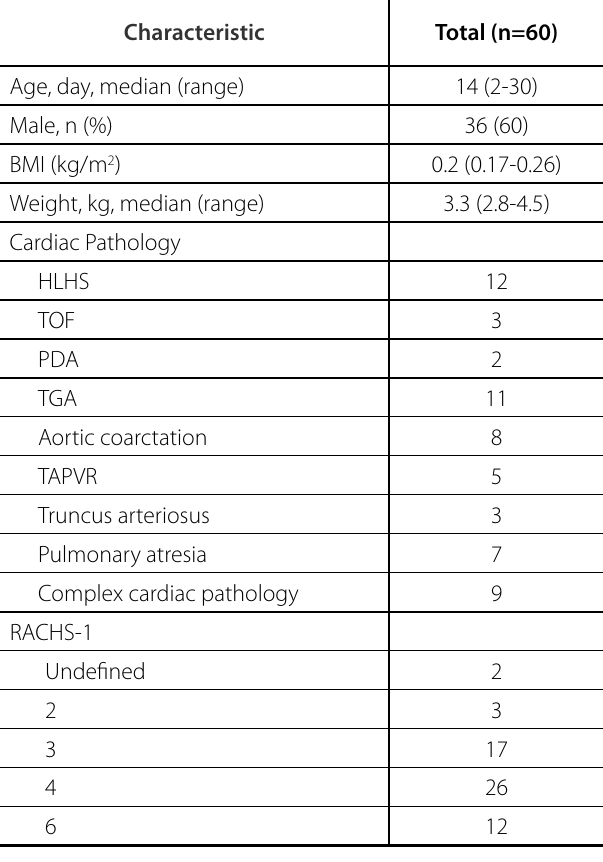
Table 1. General clinical characteristics of the cases.